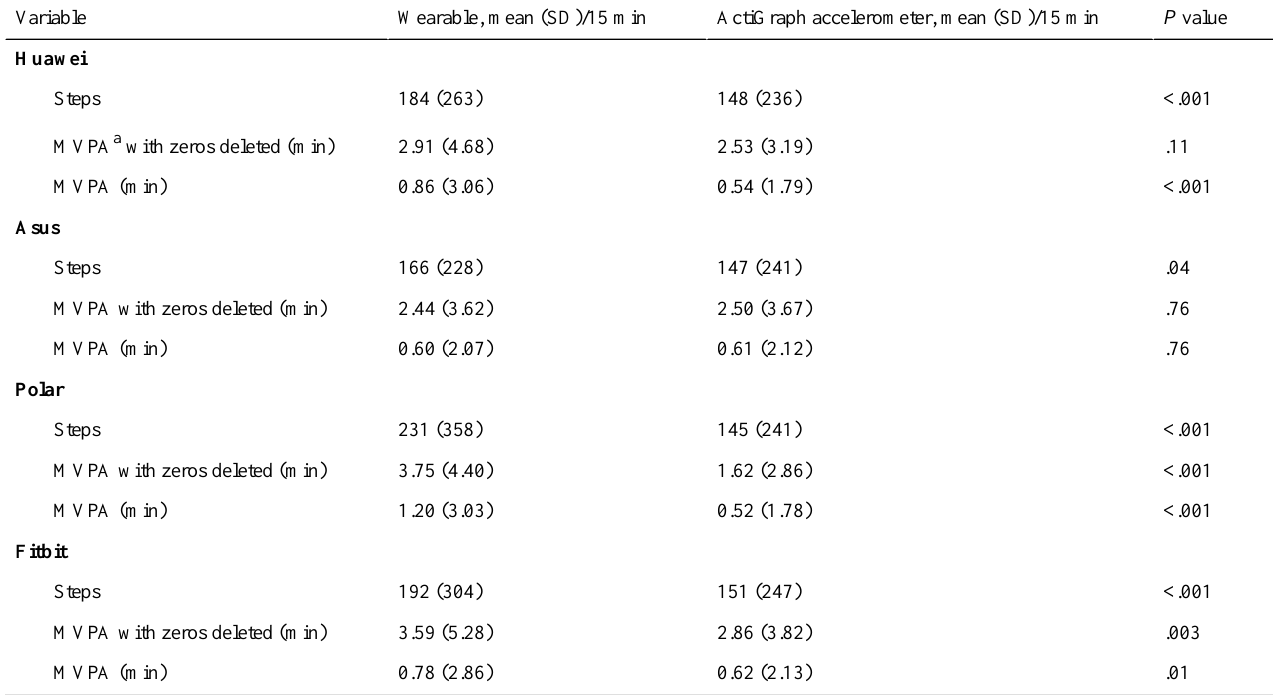
Table 4. Mean steps and minutes of moderate to vigorous physical activity per 15 min measured by Huawei, Asus, Polar, and Fitbit and the corresponding ActiGraph measurements and statistical significance ( P value) of the difference between the ActiGraph accelerometer and the